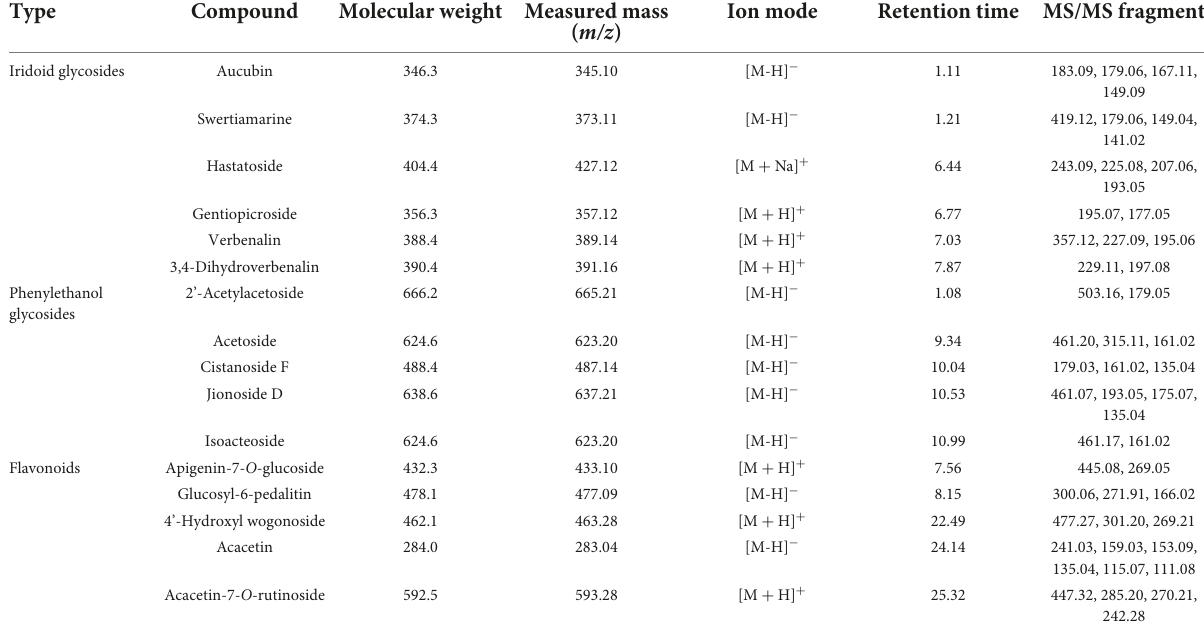
TABLE 1 Result of UPLC-MS in Verbena officinalis